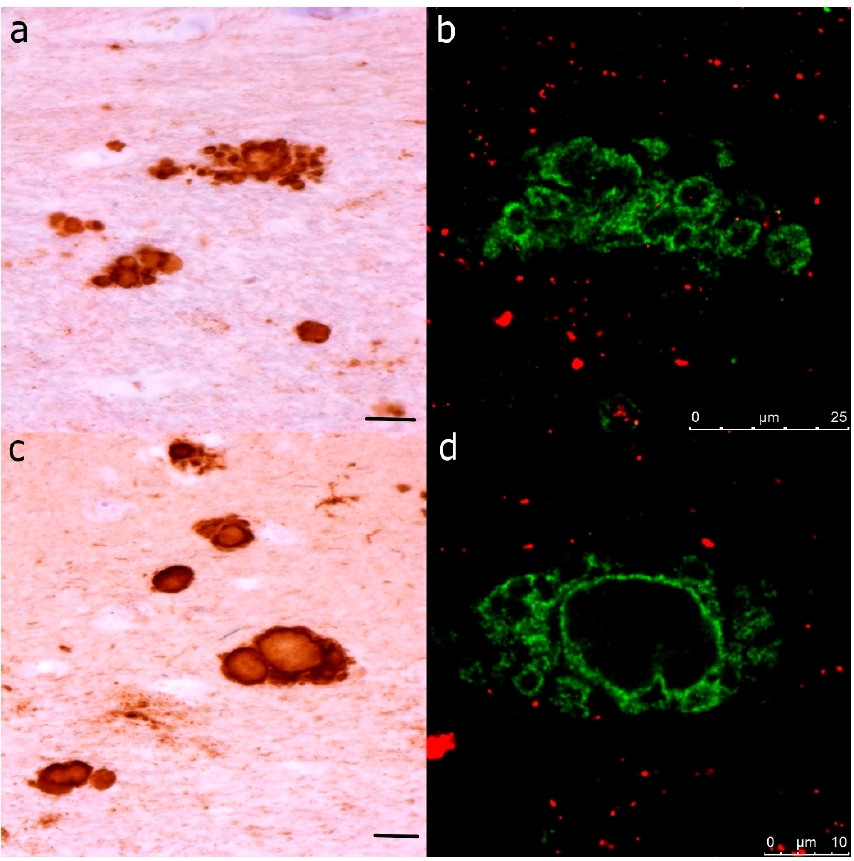
Figure 1. Illustration—Parallel observation of ( a , b ) multicentric and ( c , d ) solitary kuru-like plaques with centrally bright cores visualized using immunohistochemistry and immunofluorescence. ( a , c ) Primary antibody in immunohistochemical images: PrP (mouse monoclonal antibody). The secondary antibody was conjugated with horseradish peroxidase staining DAB. The original magnification was 100×. ( b , d ) Primary antibodies in immunofluorescent images: PrP (rabbit recombinant monoclonal antibody, green color) + AT8 (mouse monoclonal antibody, red color). The secondary antibody was conjugated with either Alexa Fluor ® 488 (anti-rabbit IgG, green) or Alexa Fluor ® 568 (anti-mouse IgG, red). Scale bars indicate 25 µm in ( a , b ) and 10 µm in ( c , d ).